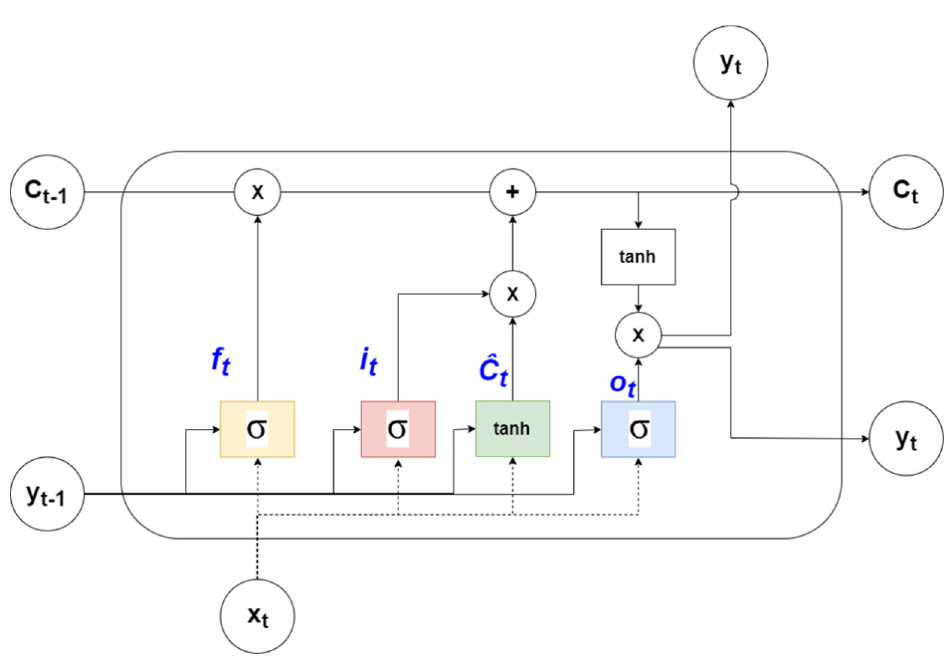
Figure 2. Long short-term memory networks (LSTM) cell.